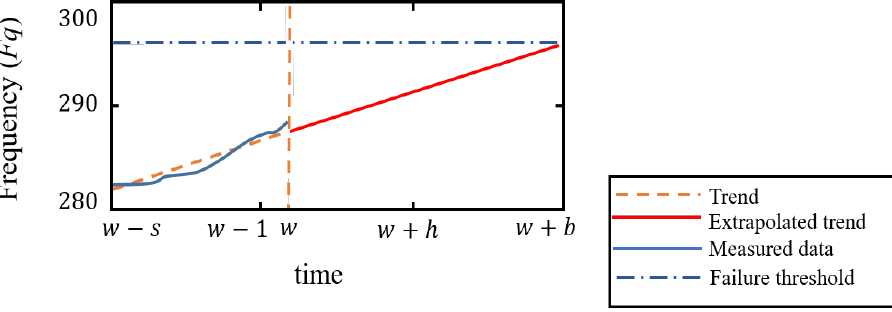
Figure 8. Pseudo-algorithm for the diagnosis process in step v. Once the results from the failure diagnosis and failure prognosis processes are obtained, they should be delivered to the system operators, who shall take decisions about the most suitable actions to be performed. 5. Validation of the Proposed Method To validate our hypothesis (i.e., variations on the frequency and duration of SOMs provide sufficient means for conducting failure prognosis in running time) we conducted an experiment on a small-scale cyber-physical greenhouse testbed. Two aspects were evaluated: (1) 𝐹𝑞 and 𝐷 provide sufficient information for accurately tracing the fault evolution process. (2) 𝐹𝑞 and 𝐷 contain sufficient information for estimating the TTF and diagnosing the forming failure mode. The above-mentioned hypothesis, as well as the proposed prognosis method were evaluated through an experimental approach that aims to provide real-life conditions for analyzing fault manifestations. For this purpose, a testbed of a small-scale cyber-physical greenhouse was designed